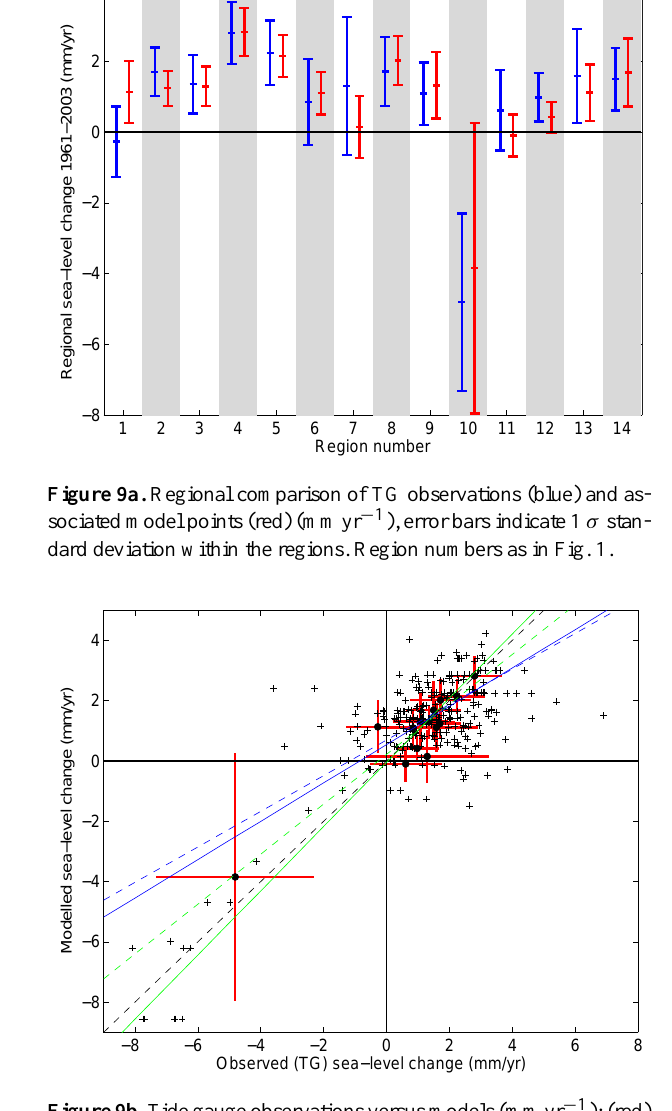
Figure 9b. Tide gauge observations versus models (mmyr − 1 ): (red) regional mean ± 1 σ standard deviation within the regions; (black) individual values. Linear least squares fit for (green-solid) all re- gional means, (green-dashed) regional means except region 10, (blue-solid) all local values, and (blue-dashed) local values except region